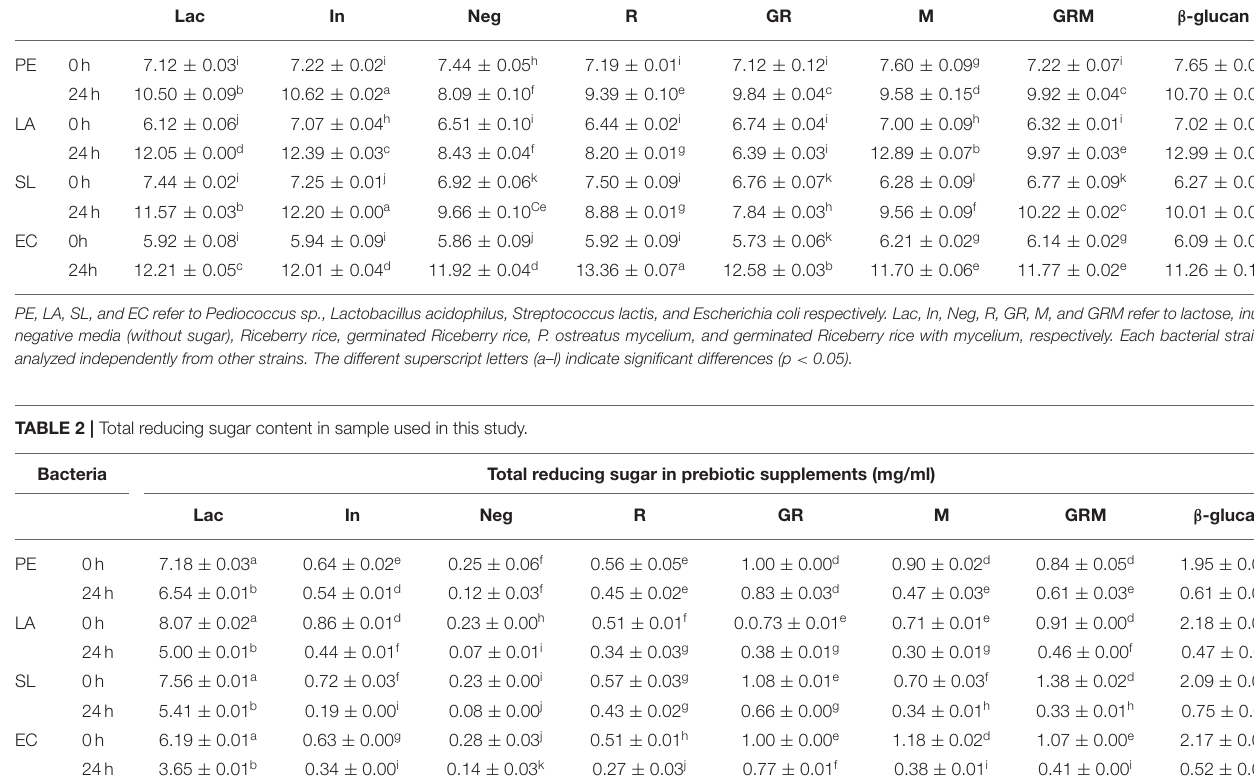
TABLE 1 | Cell density at 0 and 24h, reported as Log CFU/ml, for bacterial cultures grown in different treatments. Bacteria Log of growth prebiotic supplements (CFU/ml)